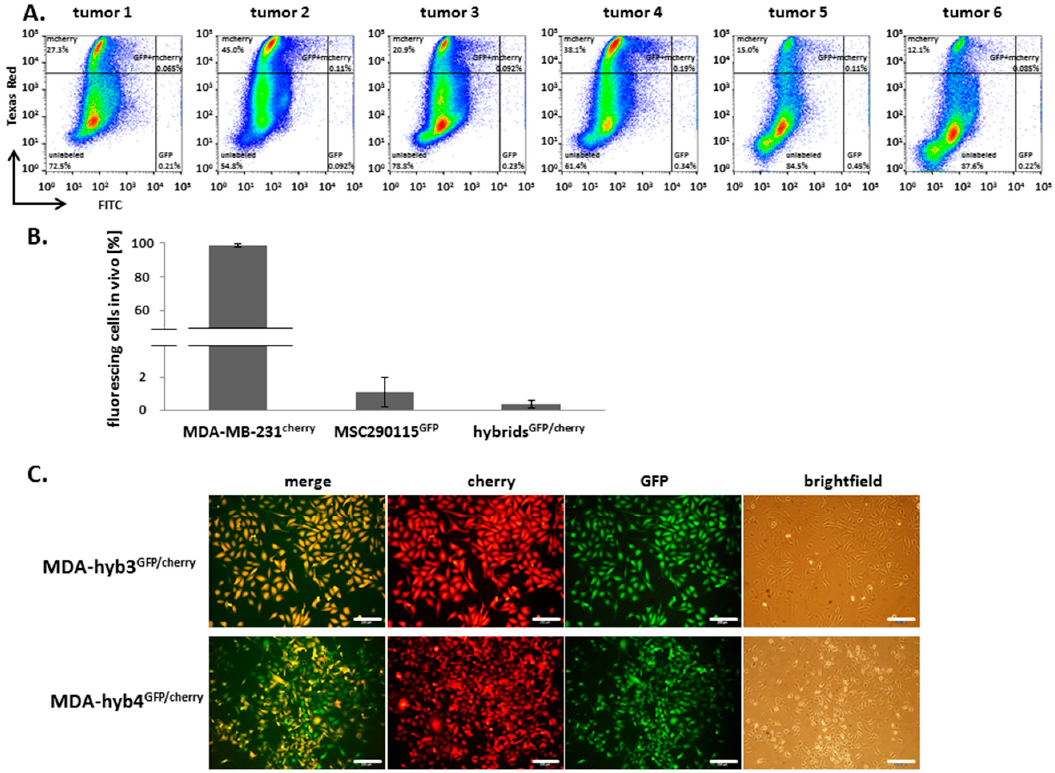
Figure 4. After dissociation of 6 in vivo tumor tissues, supernatants were analyzed by flow cytometry ( A ) and quantified for MDA-MB-231 cherry , MSC290115 GFP and hybrid cells GFP/cherry fluorescence. Data represent the mean ± S.D. from all 6 tumor tissue supernatants ( B ). Hybrid cell formation was observed in 2D co-cultures between MSC290115 GFP and MDA-MB-231 cherry resulting in GFP and cherry positive yellow fluorescing cells. Separation of hybrid cells was performed by fluorescence-activated cell sorting (FACS) and subsequent single cell cloning. Two different clones (MDA-hyb3 and MDA-hyb4) were isolated ( C ). Bars represent 200 µm.